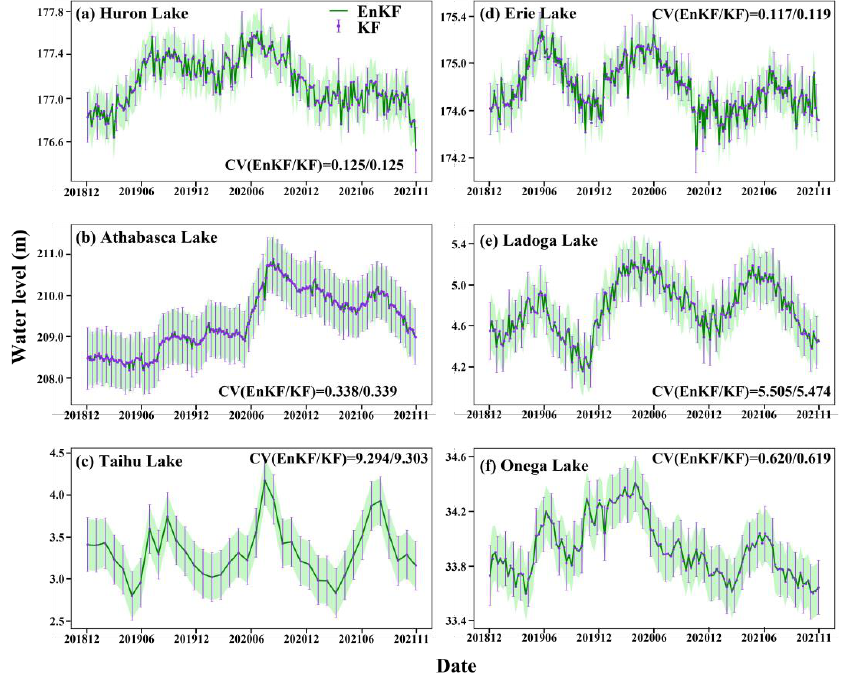
Figure 5. Comparison of water level series of lakes in different sizes by the two Kalman filter methods (KF and EnKF) over ( a ) Huron Lake, ( b ) Athabasca Lake, ( c ) Taihu Lake, ( d ) Erie Lake, ( e ) Ladoga Lake, and ( f ) Onega Lake.